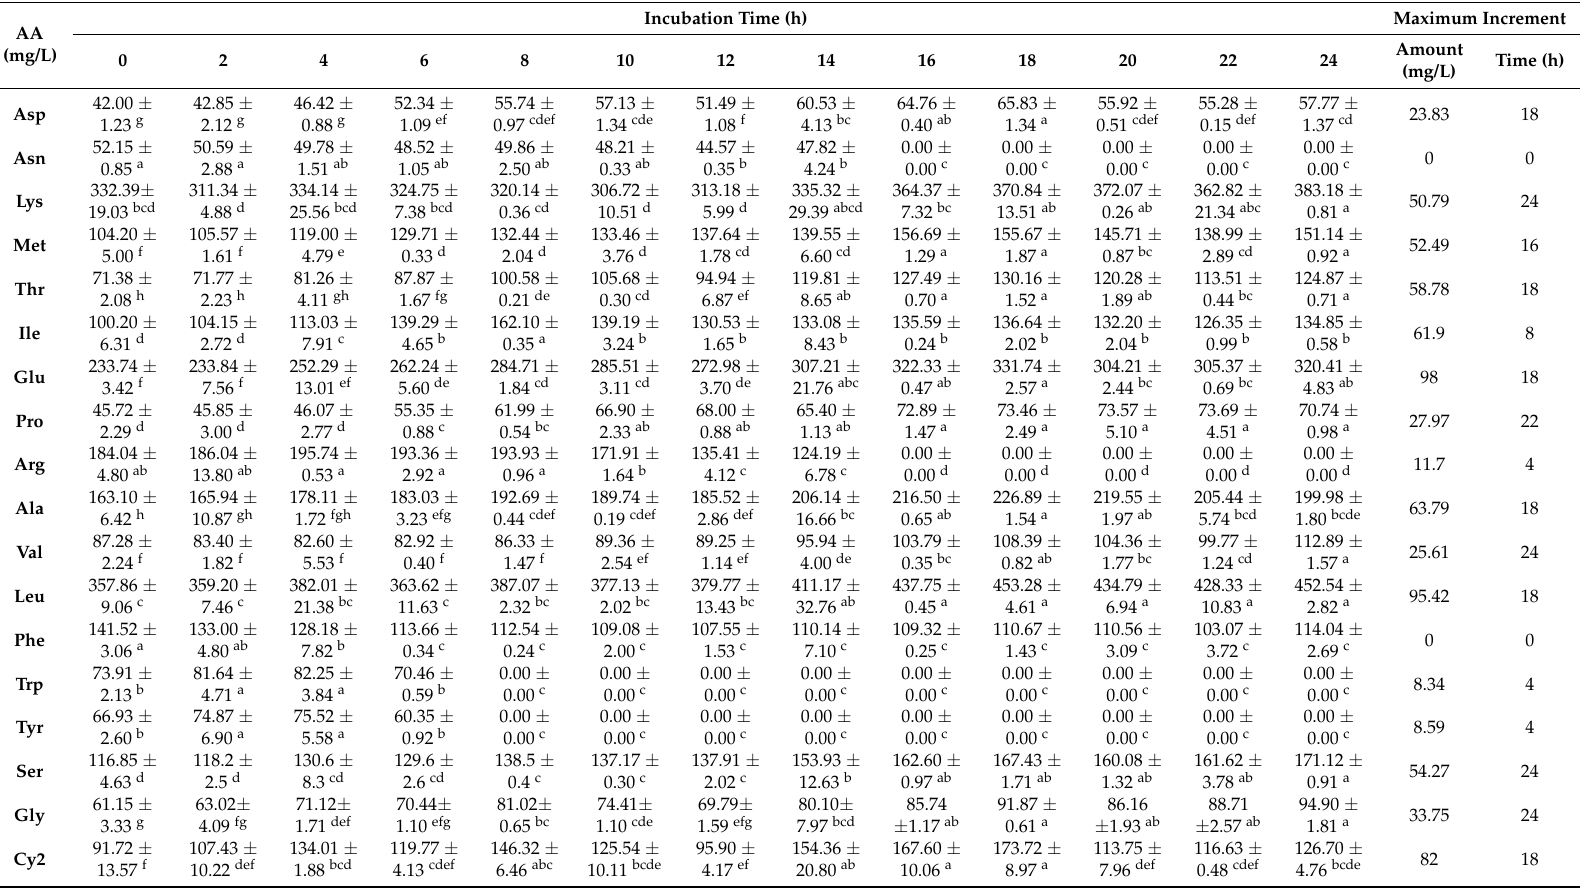
Table 2. The amino acid production profile of P. pentosaceus